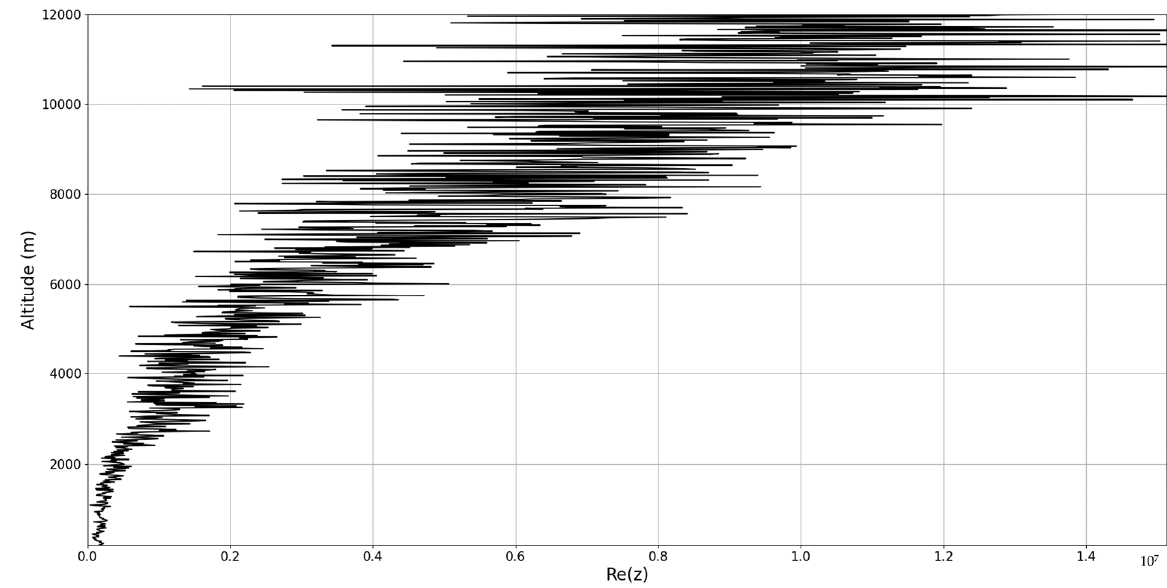
Figure 17. Re profile, λ = 1064 nm , Gala ț i, Romania, 22 December 2021.